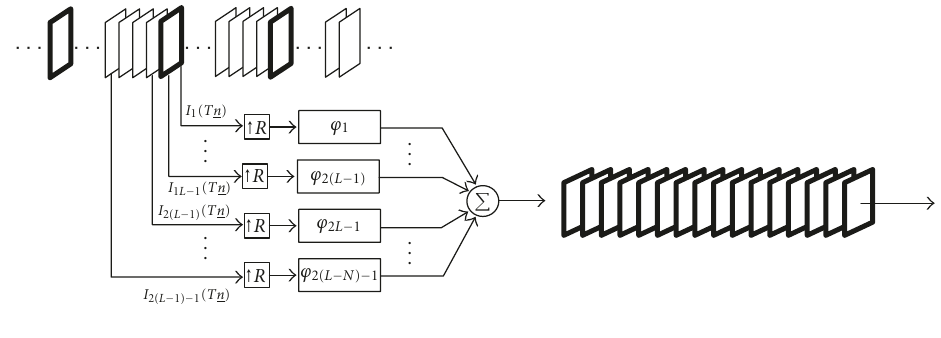
Figure 10: The reconstruction process.